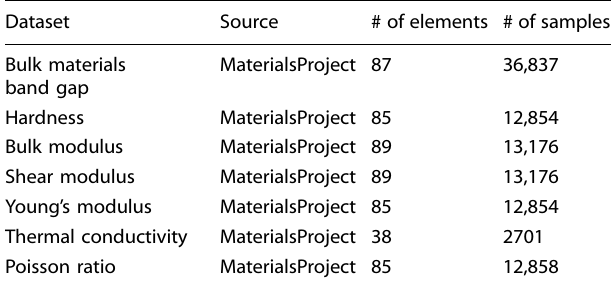
Table 2. Datasets used for training structure-based DeeperGATGNN